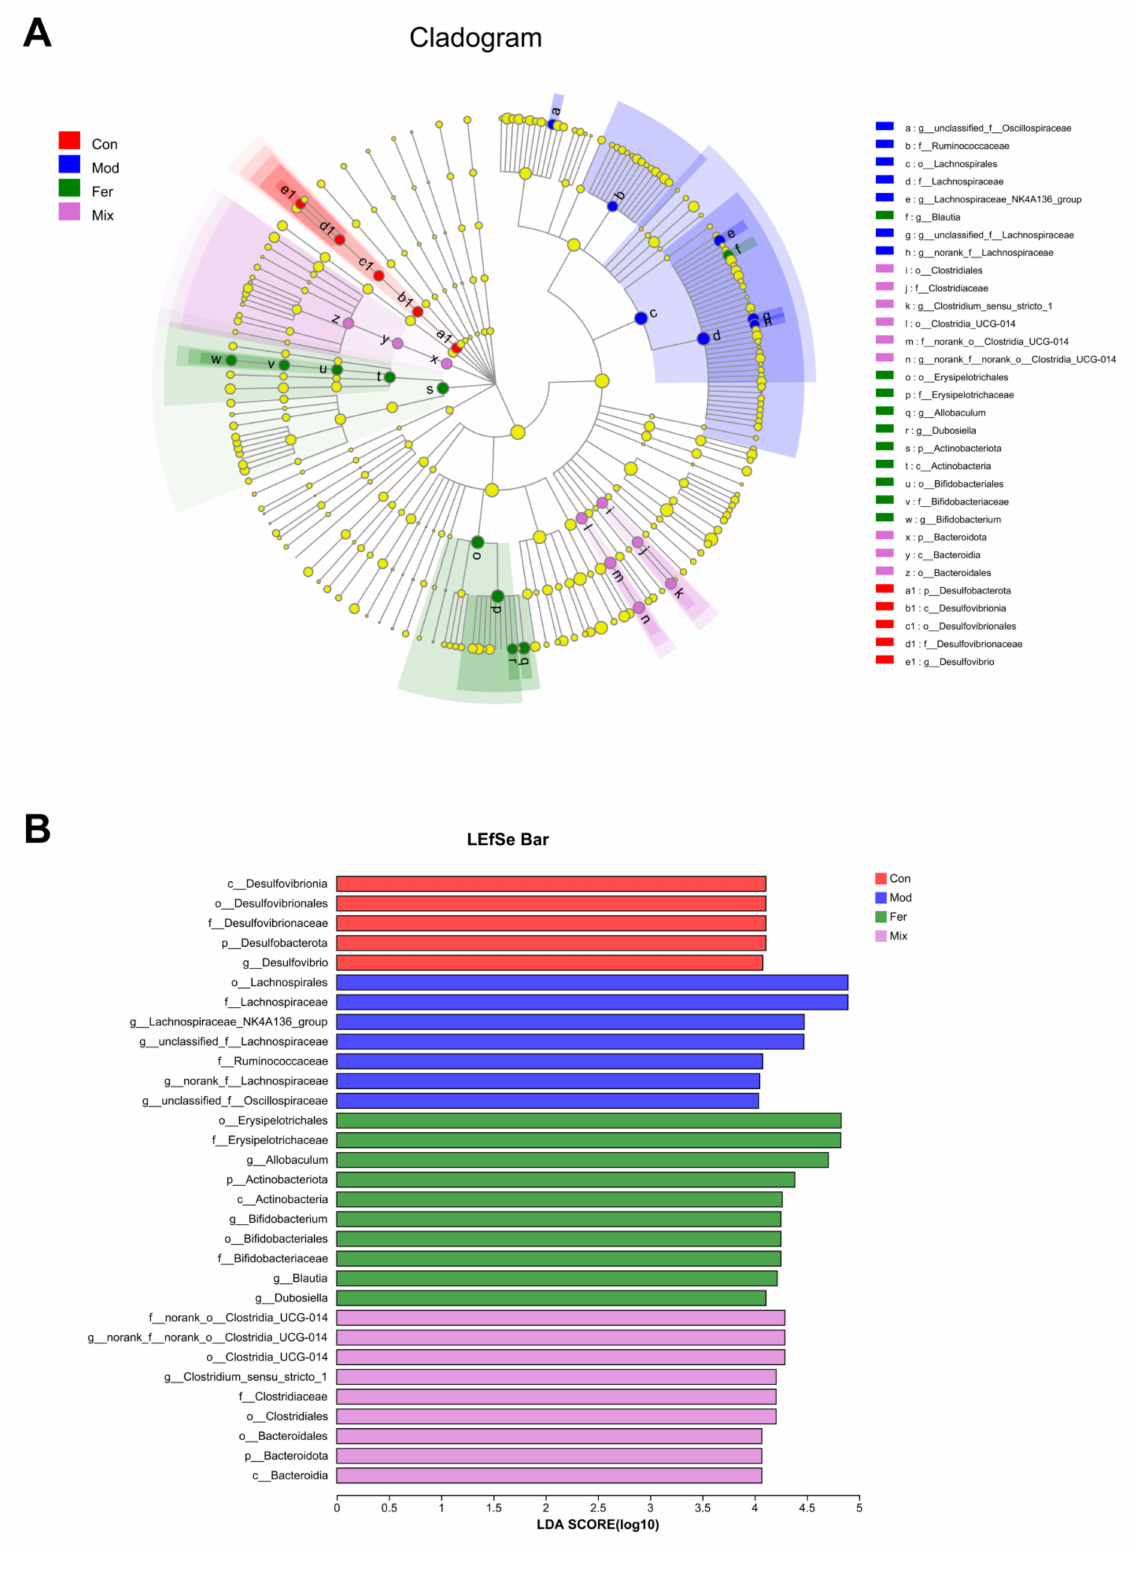
Figure 7. Changes in gut microbiota at different levels and interactions between them. LEfSe analysis was performed to identify the taxa that changed significantly. A cladogram ( A ) was used to analyze the changes in the gut microbiota occurring in each group across taxa, and LDA score histograms ( B ) were used to analyze the bacterial markers in each